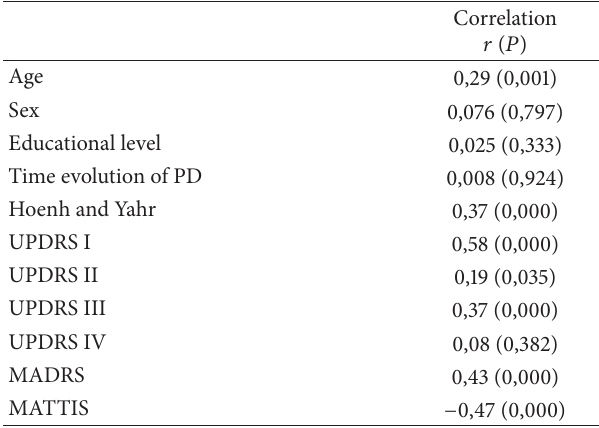
Table 4: Analysis of correlations between the total LARS score and the demographic and clinical